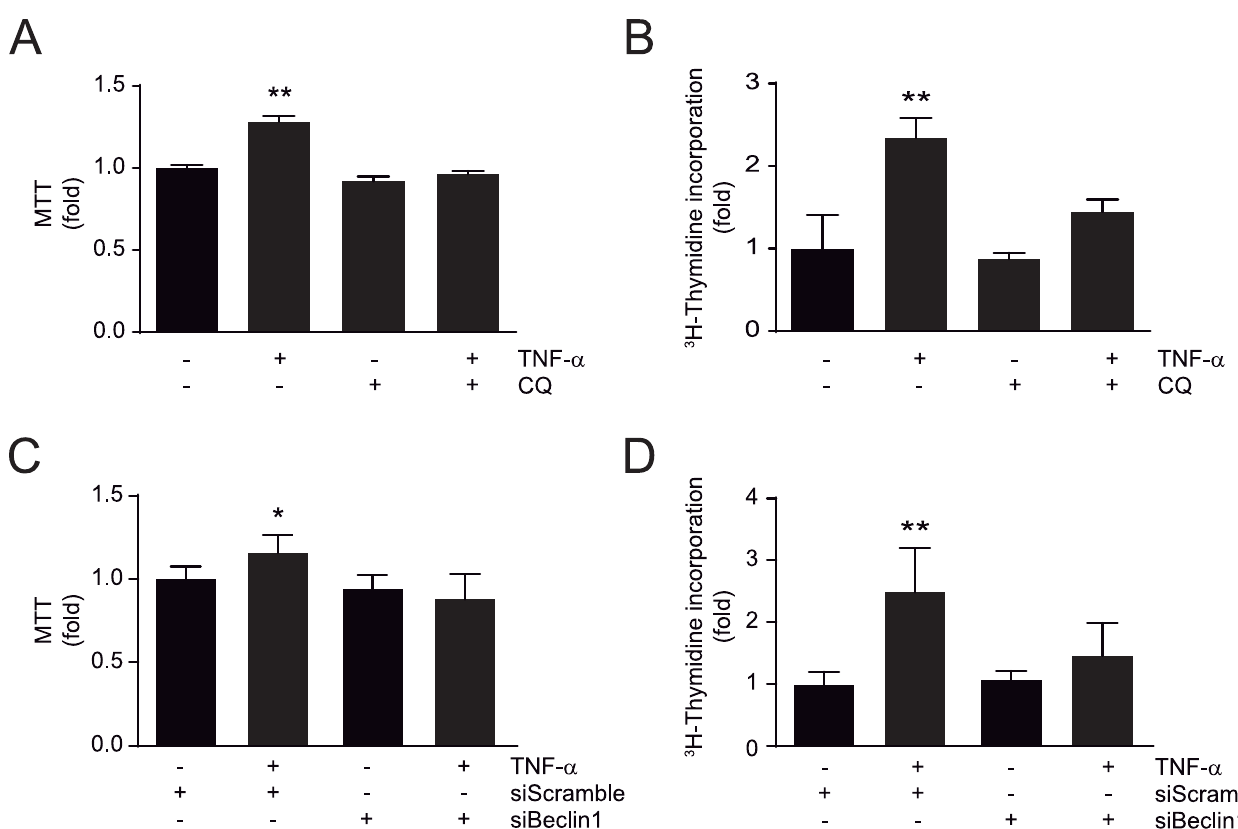
Fig 4. TNF- α induces proliferation of A7r5 cells through an autophagy-dependent mechanism. ( A ) Determination of proliferation by the MTT assay and ( B ) incorporation of [ 3 H]-thymidine in A7r5 cells treated with TNF- α (100 ng/mL) for 24 h in the presence or absence of chloroquine (CQ, 20 μmol/L) during the last 4 h of TNF- α stimulus (n = 4; (cid:3)(cid:3) p < 0.01 vs control) or ( C and D ) siScramble and siBeclin1 (n = 4; (cid:3) p < 0.05, (cid:3)(cid:3) p < 0.01 vs control). Data are expressed as mean ± SEM and analyzed by one-way ANOVA, followed by Holm Sidak ( A and C ) and Dunnett ( B and D ) post-tests.